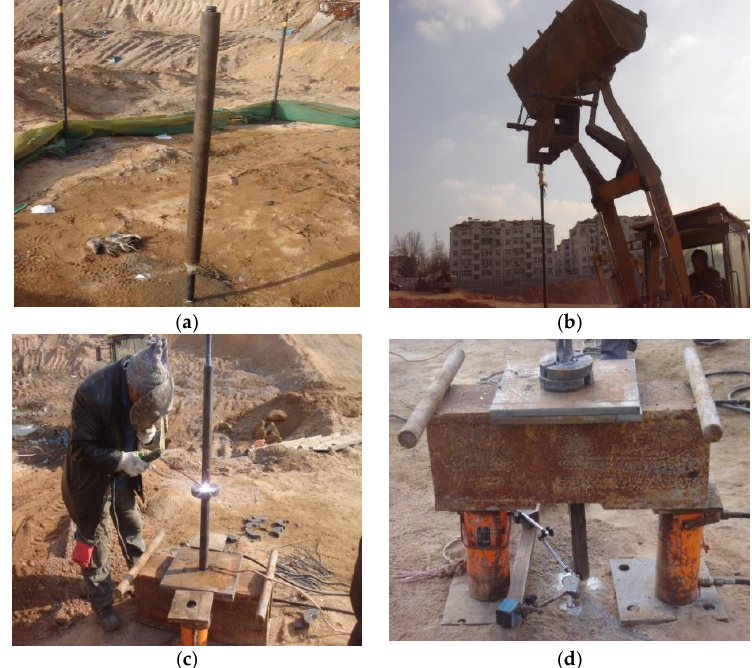
Figure 5. Pulling test set-up in field: ( a ) steel bar fixed with GFRP anchors; ( b ) loading device installation; ( c ) wedding circular steel plates; and ( d ) pulling-out.